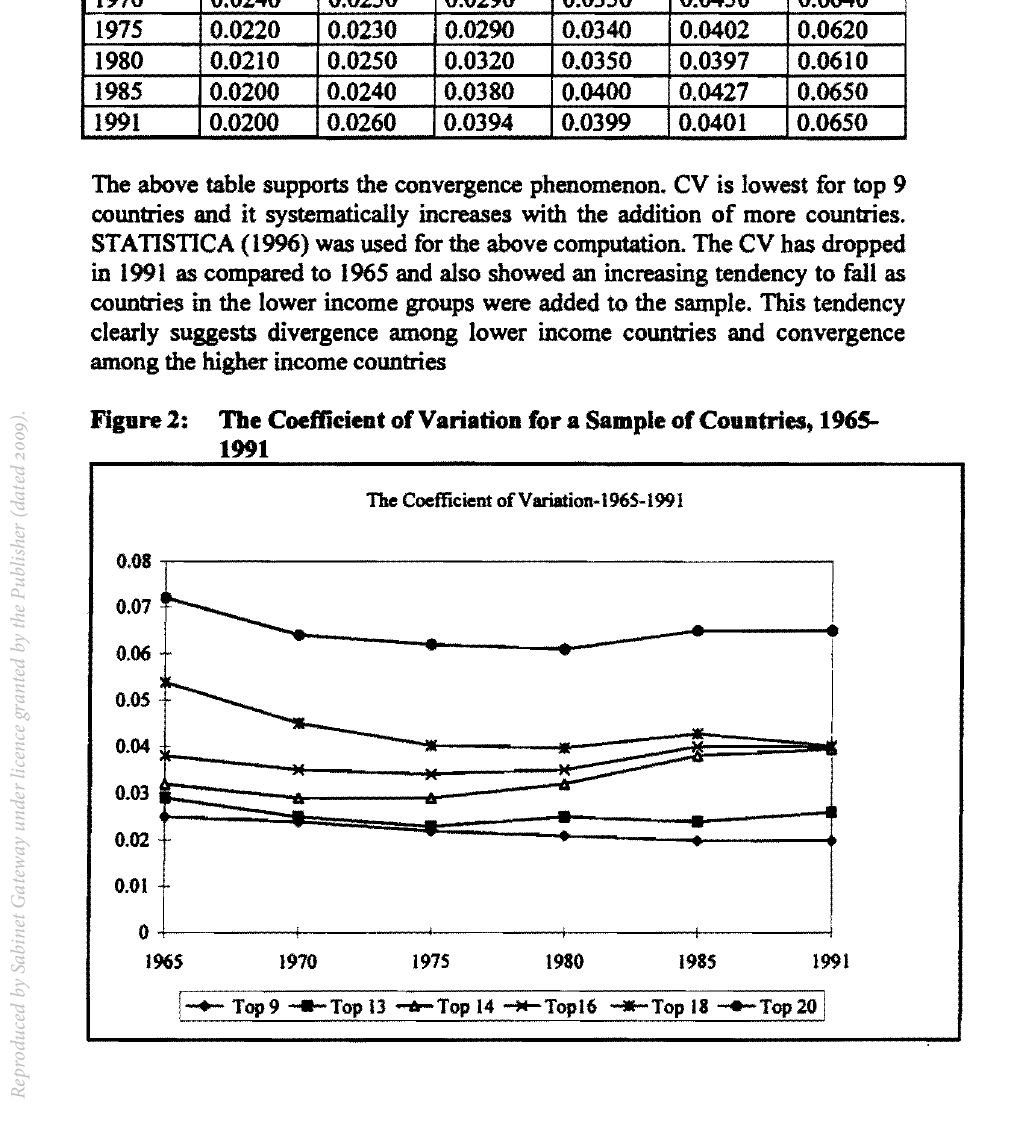
The Coefficient of Variation for a Sample of Countries,